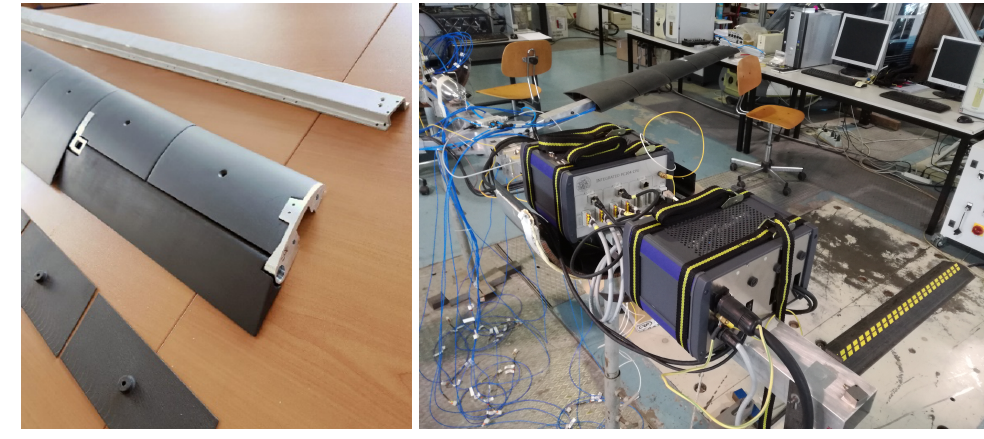
Figure 2. Detail of the X-DIA